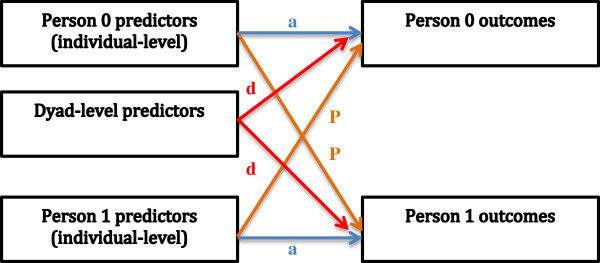
Schematic of the actor-partner interdependence model (APIM) framework, adapted from Cook & Kenny, 2005 [32]. a, actor effects. p, partner effects. d, dyad-level effects. Within-dyad residual errors between outcomes and predictors are not shown. Individual-level predictors (actor and partner): Age, race/ethnicity, education, sexual orientation, serostatus, unprotected anal intercourse with a man other than main partner in past 3 months, and agreements about sex outside the relationship. Dyad-level predictors: Duration of relationship with main partner (average of partner responses); unprotected anal intercourse in last year with main partner (reported by either partner); dyadic differences in age, education, race/ethnicity, sexual orientation, and agreements about sex outside the relationship. Outcomes: 1) IPV experienced from the study partner in the past three months, 2) coercion experienced from the study partner to participate in the study.